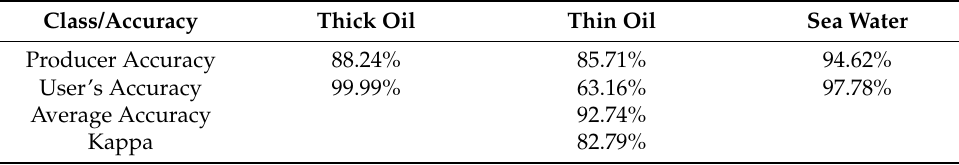
Table 8. Classification accuracies of random forest classifier in Case 6.